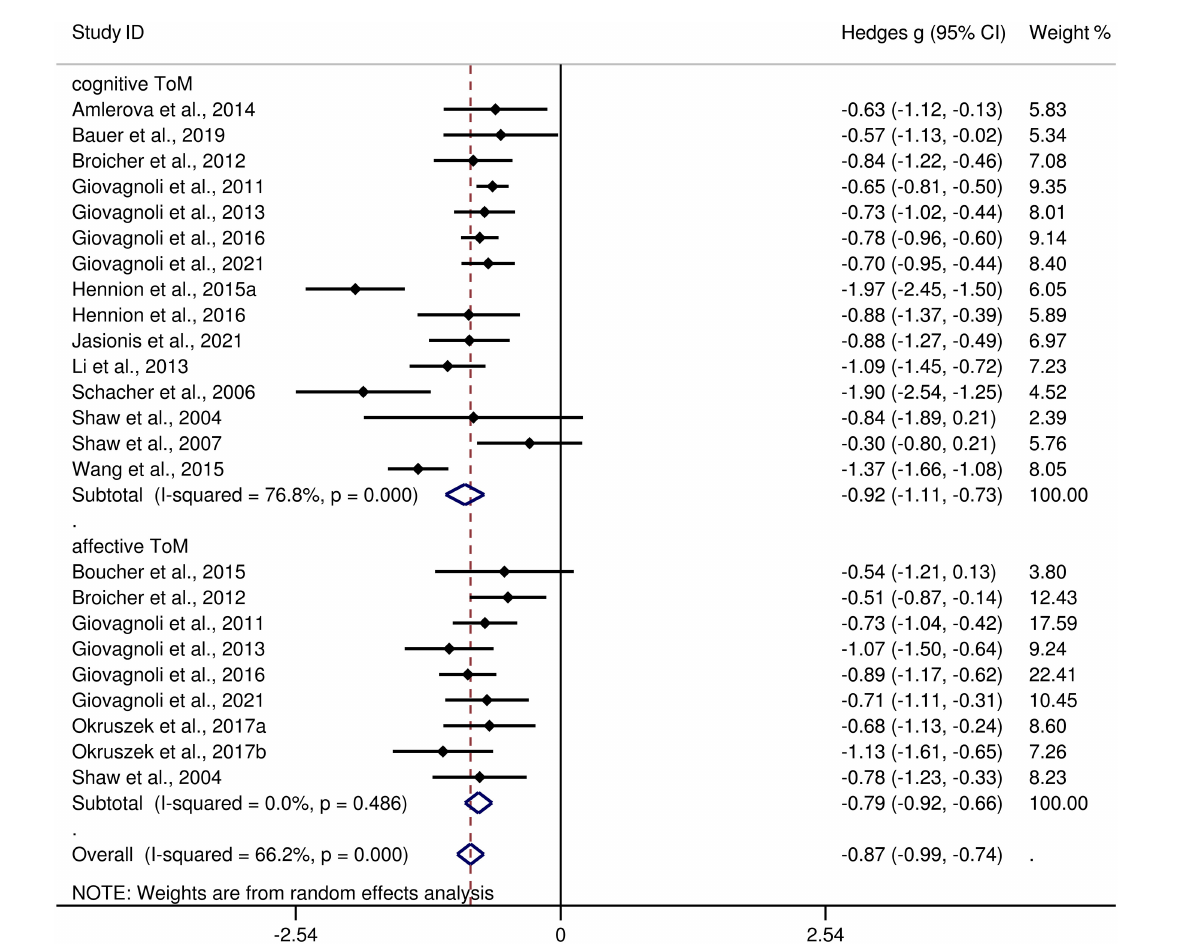
FIGURE3 Forest plots showing effect size estimates (Hedges g) for cognitive ToM and affective ToM differences between adults with TLE and healthy controls. ToM, theory of mind; CI, confidence interval; TLE, temporal lobe